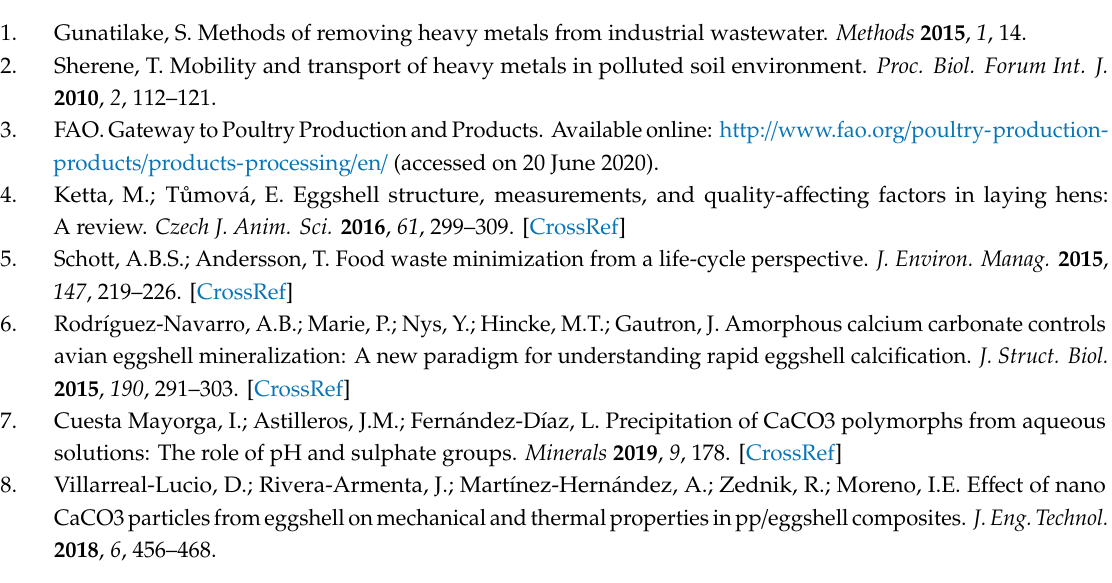
Table S1. Experimental data of kinetics of Eggshell and the composite for Pb 2 + As 5 + and Hg 2 + ; Table S2. Experimental data of isotherms for Pb 2 + As 5 + and Hg 2 + onto Eggshell and